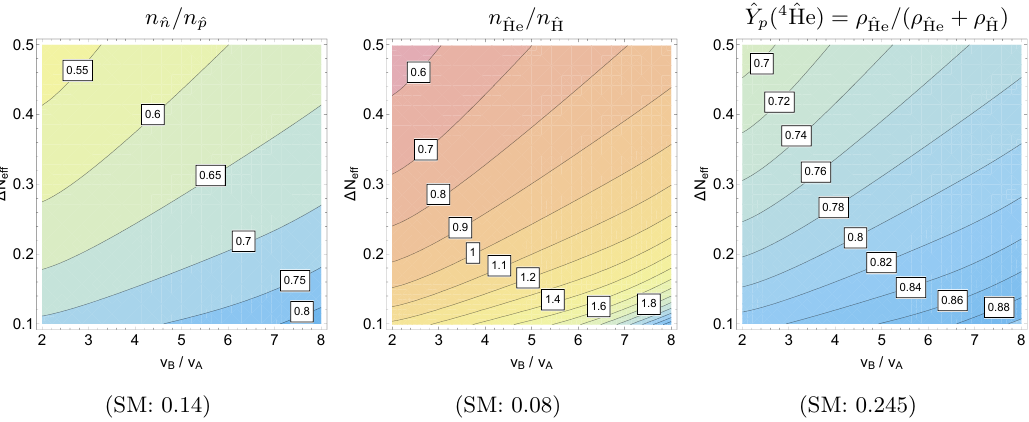
Figure 1 . From left to right: the mirror ( n=p ) ratio, ratio of the mirror 4 He and H number density, and ratio of the mirror 4 He and H matter density in MTH model. We are interested in the region 3 v B =v A 5. The corresponding value in the visible sector is indicated below each (cid:20) (cid:20)